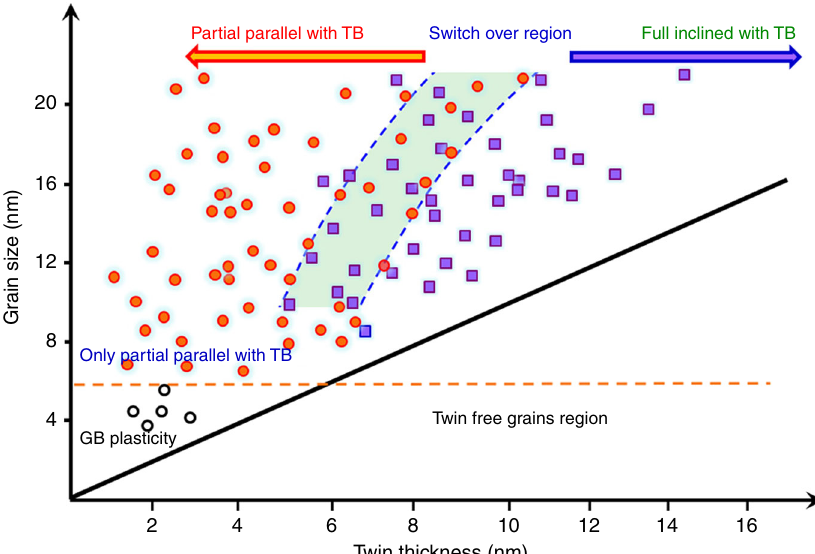
Fig. 5 Statistical results of the plasticity for twin-structure NC and twin free NC metals. For d > ∼ 10 nm, there is a transition from full dislocation intersecting with the TB switch to partial dislocations parallel with TBs, and the critical TT for the deformation transition is grain-size dependent. For d = 6 – 9 nm, partial dislocation parallel with the TBs dominates. For d < ∼ 6 nm, there is a transition from dislocation-controlled plasticity switching to GB- mediated plasticity. The black dots and red squares correspond to statistical results of plasticity events in twin-free NC